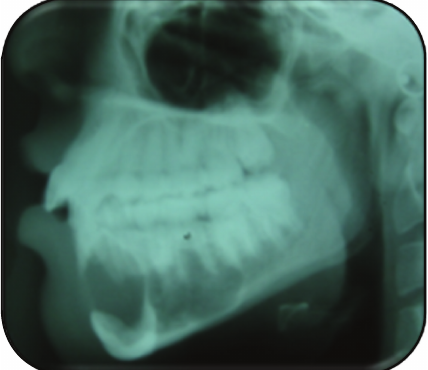
Figure 5: Lateral cephalogram radiograph.